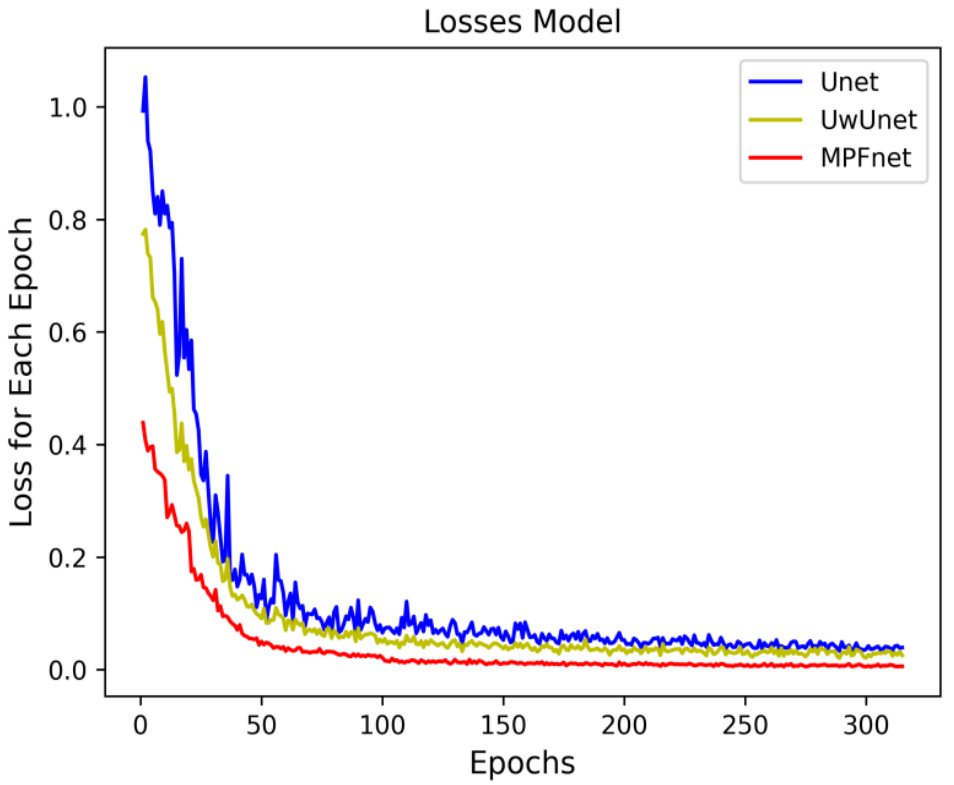
Figure 1. The neural network training curves for three prediction models include Unet, UwUnet, and MPFnet.